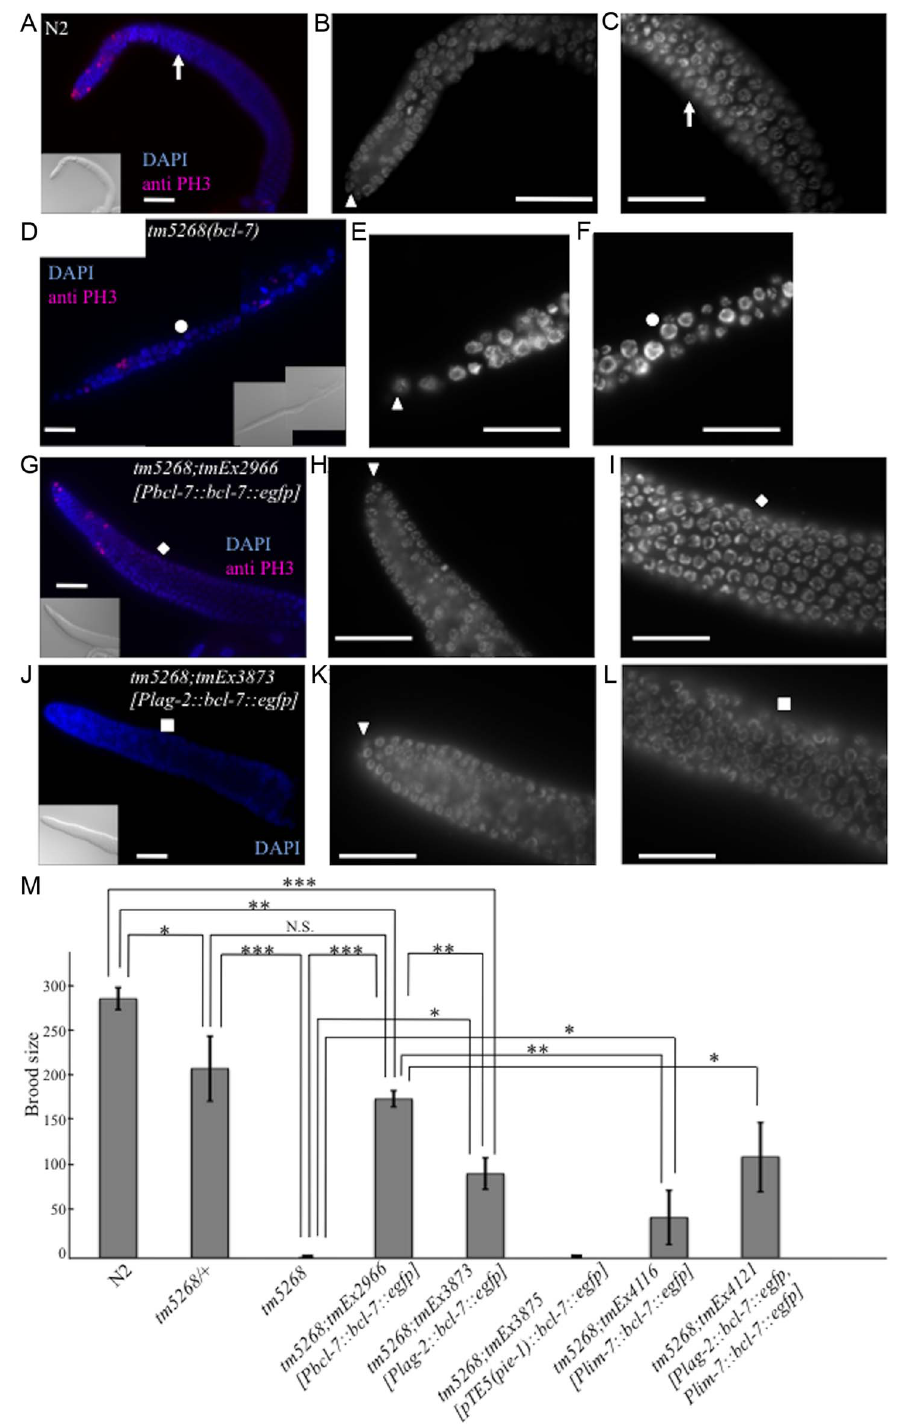
Fig. 3. Knockout of bcl-7 affects gonadal development and germ cell proliferation in Caenorhabditiselegans . A–C : A dissected adult germline of a wild-type adult hermaphrodite. A dissected gonad stained with DAPI (blue) and an anti-PH3 antibody (pink) as a mitotic cell-specific marker ( A ), and the regions of mitosis ( B ) and meiosis ( C ) of the gonad stained with DAPI. The arrowhead indicates a distal tip cell (DTC). The white arrows indicate the corresponding position of the gonad. D–F : A dissected germline of a tm5268 adult hermaphrodite. A dissected gonad stained with DAPI (blue) and an anti-PH3 antibody (pink) as a mitotic cell-specific marker (D), and the regions of mitosis ( E ) and meiosis ( F ) of the gonad stained with DAPI. The arrowhead indicates a DTC. The white circles indicate the corresponding position of the gonad. G–I : A dissected germline of a tm5268;tmEx2966 adult hermaphrodite. A dissected gonad stained with DAPI (blue) and an anti-PH3 antibody (pink) as a mitotic cell-specific marker (G), and the regions of mitosis ( H ) and meiosis ( I ) of the gonad stained with DAPI. The arrowhead indicates a DTC. The white rhomboid indicates the corresponding position of the gonad. J–L : A dissected germline of a tm5268;tmEx3873 adult hermaphrodite carrying Plag-2::bcl-7::egfp as a DTC- specific rescue construct. A dissected gonad stained with DAPI (blue) ( J ), and the regions of mitosis ( K ) and meiosis ( L ) of the gonad stained with